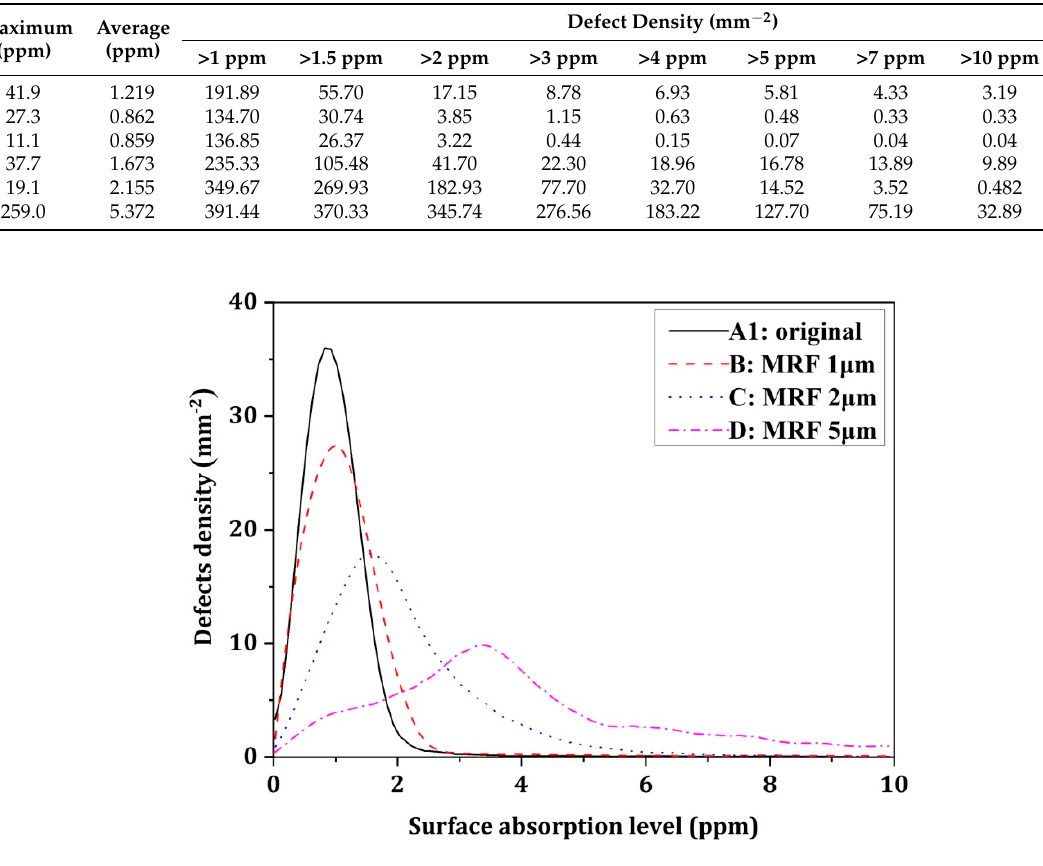
Figure 3. Weak absorption distribution curves of all polished sample surfaces.